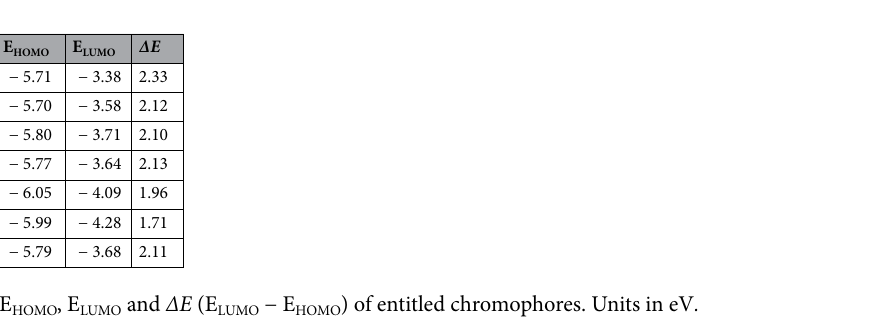
Figure 3. The optimized structures of TPDR and TPD1 – TPD6 at MPW1PW91 6-31G(d,p). Figures are made with are made with the help of GaussView 5.0 and Gaussian 09 version D.01 (https:// gauss ian. com/ g09ci tation/).